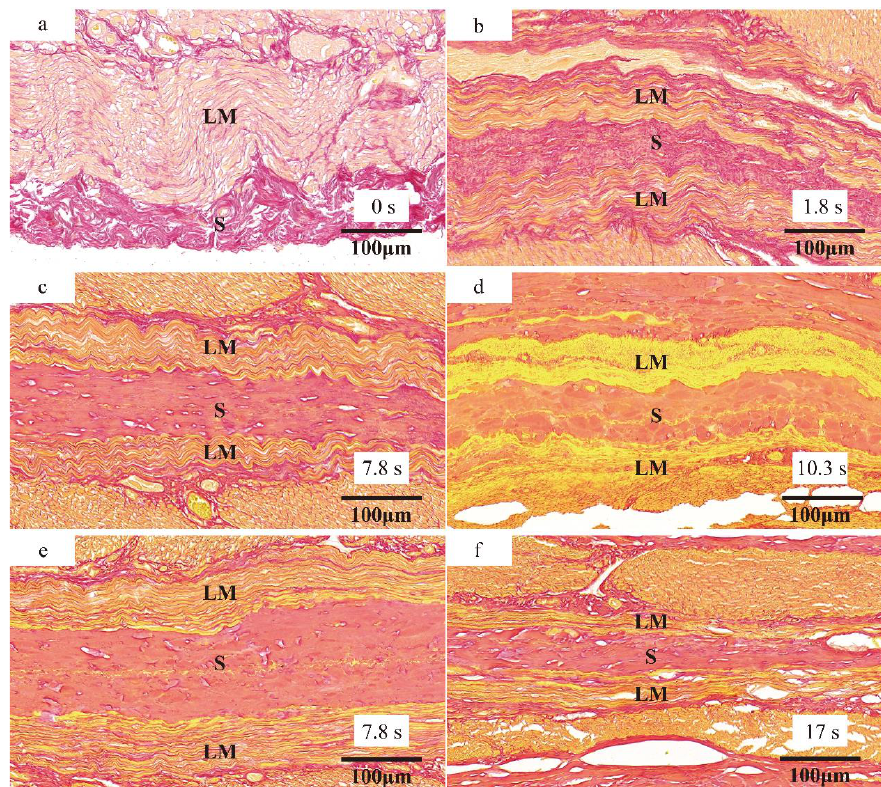
Figure 11. Longitudinal muscle (LM) and serosa (S) at the weld center: ( a ) blank control, 0 s; ( b ) 205 kPa, Period Ⅰ — 1.8 s; ( c ) 205 kPa, Period Ⅱ — 7.8 s; ( d ) 205 kPa, Period Ⅲ — 9 s; ( e ) 868 kPa, Period Ⅱ — 7.8 s and ( f ) 868 kPa, Period Ⅲ — 13 s (Sirius red, magnification ×40.0). The serosal layer contains abundant connective tissue, with fibroblasts and collagen fibers essential for forming dense junctions. The collagen fibers of the serosal layer gradually merged from a free and disordered state before welding to compression and fusion in Periods Ⅰ and Ⅱ under 205 kPa, and even penetrated the longitudinal muscle layer in Period Ⅲ . Meanwhile, the collagen fibers of the LM layer changed from disordered to wavy to fused. The scattered collagen fibers re-formed dense connections in Period Ⅲ . However, the collagen fibers of the serosal layer and the LM layer did not interpenetrate at 868 kPa.